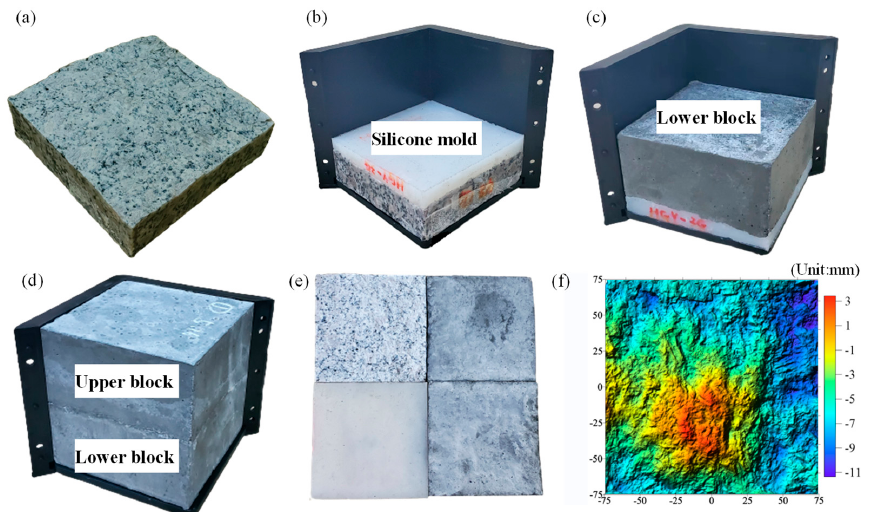
Figure 3. Schematic diagram of the joint sample preparation process: ( a ) preparing a single joint rock specimen, ( b ) using silicone to replicate the joint surface, ( c ) casting the lower block, ( d ) casting the upper block, ( e ) comparing the casting results, ( f ) scanning the sample’s surface morphology. Table 1. Physico-mechanical parameters of the joint specimens.